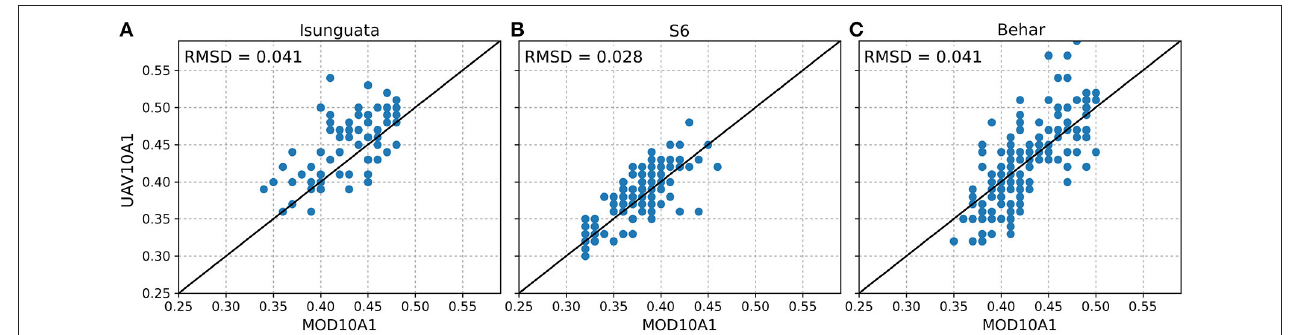
FIGURE 7 | (A) Scatter plot showing the relationship between MOD10A1 and UAV10A1-Isunguata. (B) Same as (A) but for UAV10A1-S6. (C) Same as (A) but for UAV10A1-Behar.